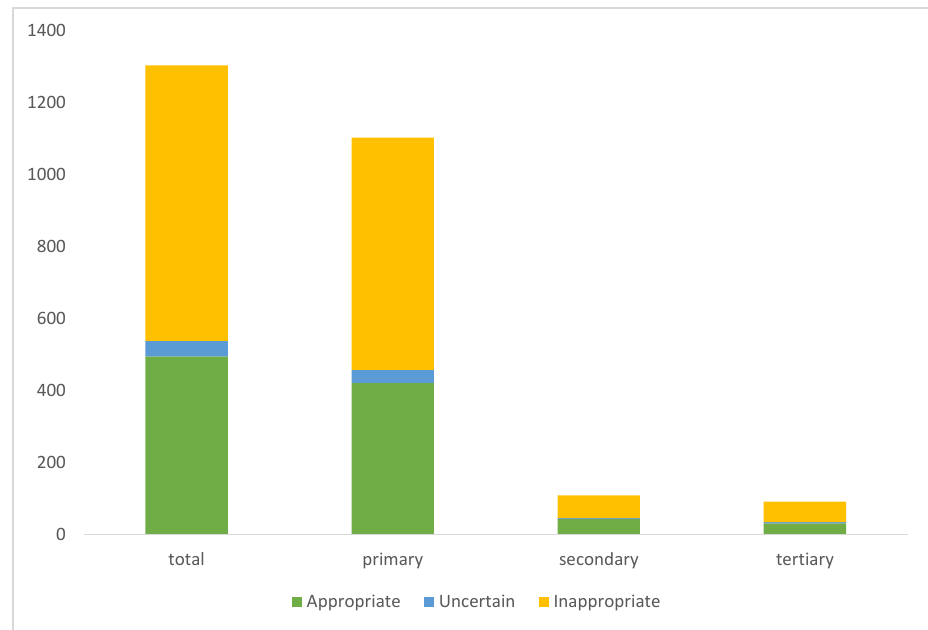
Figure 2. Absolute numbers of referrals for each appropriate use criteria in relation to referral source. The CAD pre-test probability rates were calculated following adapted ESC guide- lines [5] defining appropriate coronary CT imaging referrals in patients with an interme- diate probability and are displayed in Table 1. The total coronary revascularization rate was 39.2%, resulting in 79.5% PCI and 20.5% CABG), without differences between the groups ( p = 0.071) (Table 2 and Figure 3). Table 2. Coronary revascularization rates in the different appropriateness CCTA referral groups.